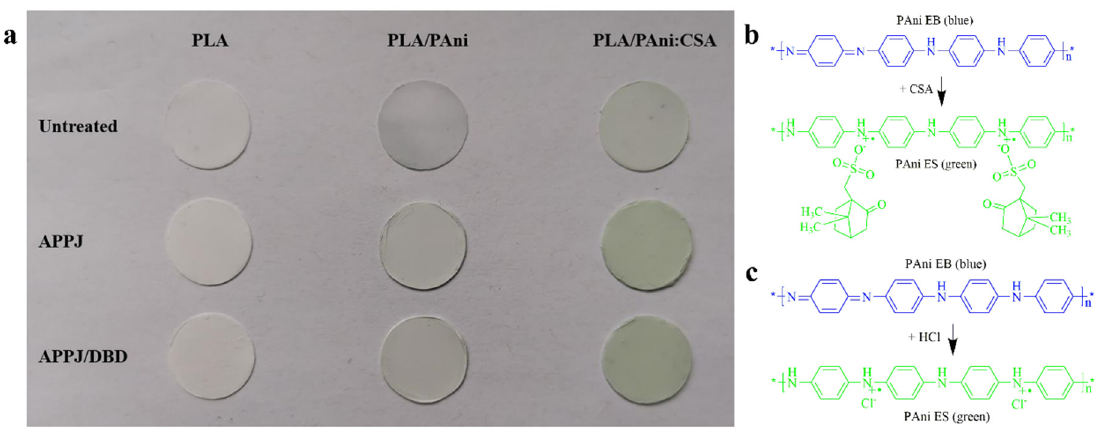
Figure 4. ( a ) Photographs of untreated, APPJ ‐ treated and APPJ/DBD ‐ treated PLA (left column), PLA/PAni (middle column), PLA/PAni:CSA (right column) nanofibrous scaffolds. Schematic repre- sentation of PAni EB doped with the organic acid CSA ( b ) and the inorganic acid HCl ( c ) generated in the APPJ treatment.